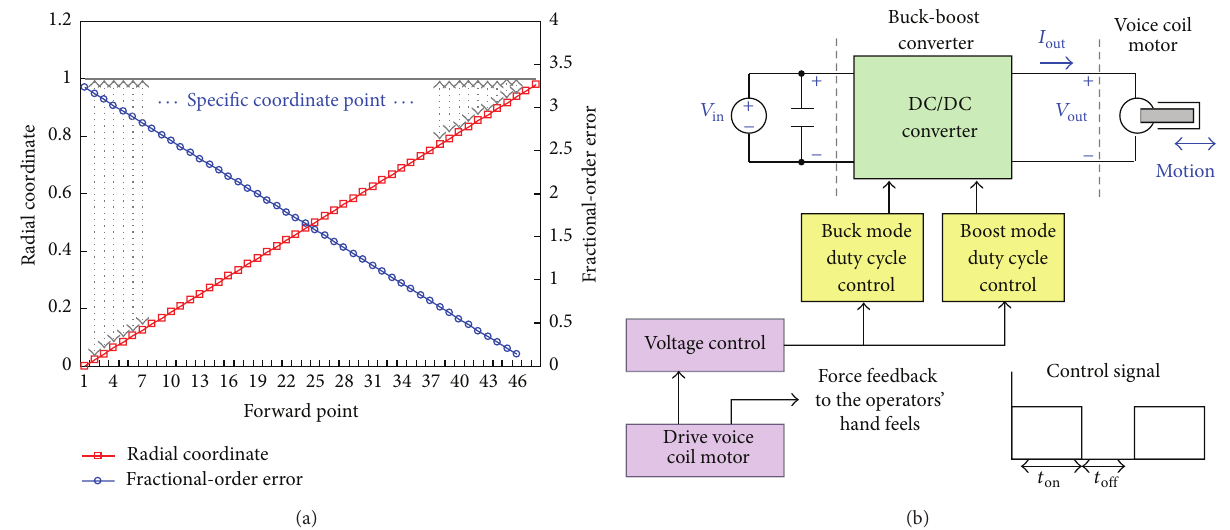
Figure 6: (a) Fractional-order dynamic errors versus catheter tip’s displacements (each forward step is 0.367 mm), (b) haptic force producer.